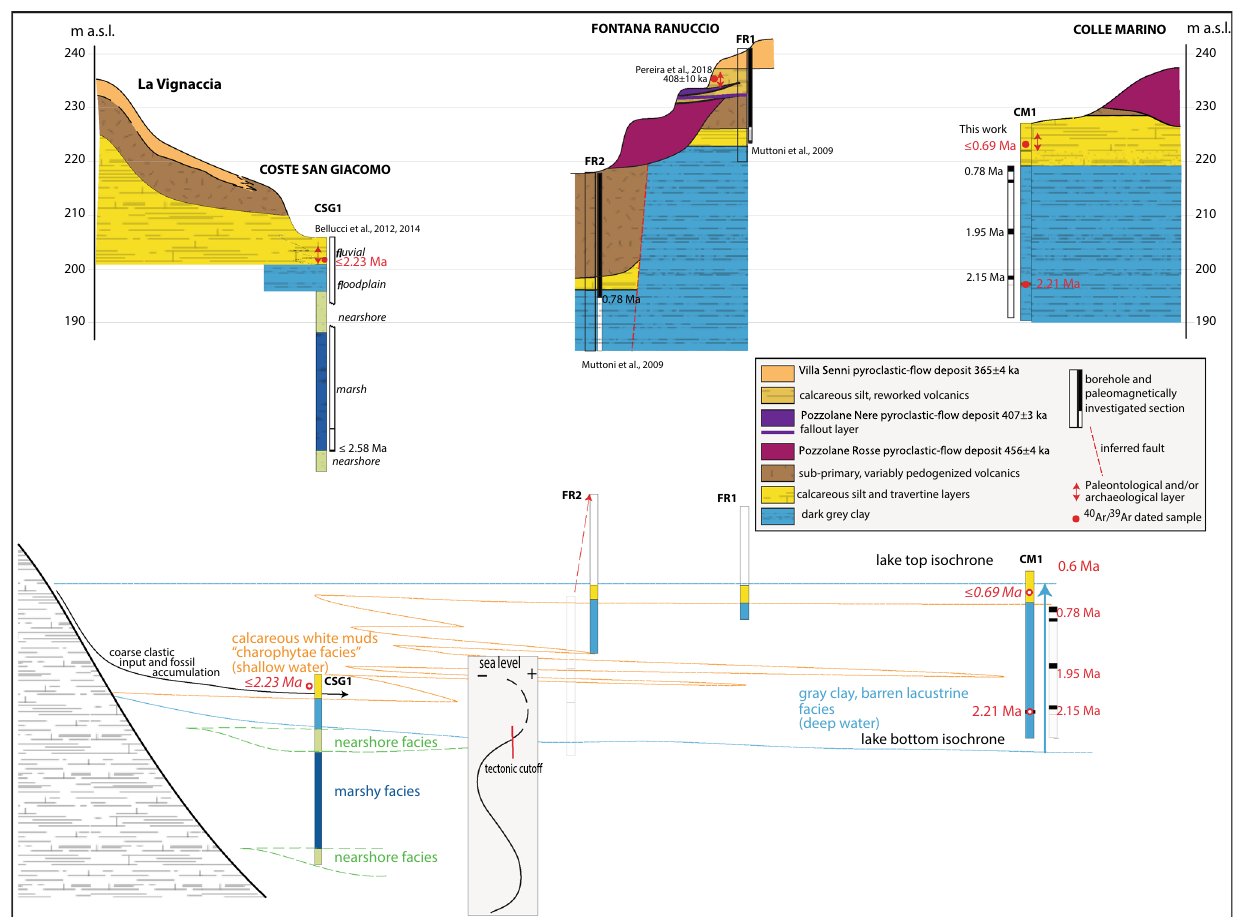
Figure 9. ( a ) Reconstruction of the stratigraphic setting of the investigated area through the cross-correlation of the borehole data achieved in the present study and in previous work at Colle Marino, Fontana Ranuccio and Coste San Giacomo. ( b ) Sketch showing the environmental evolution of the Latin Valley in the interval 2.6–0.6 Ma, after restoration of the original elevation of borehole FR2 before tectonic dislocation (see text for explanations). Drawings by